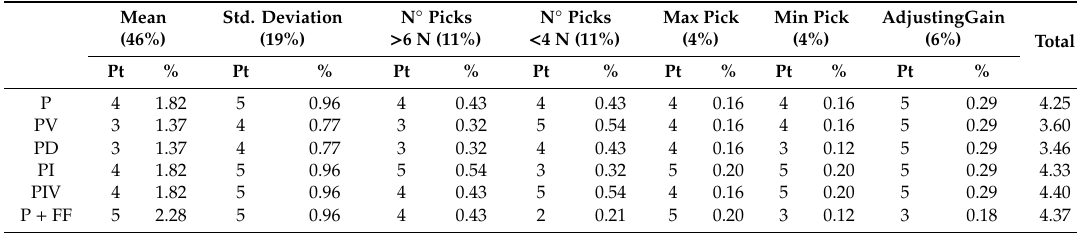
Table 7. Prioritization matrix of outer loops.